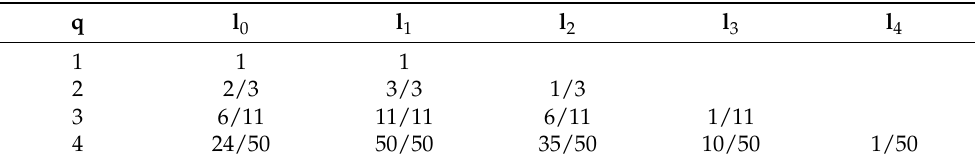
Table A3. Constant coefficients for the differential